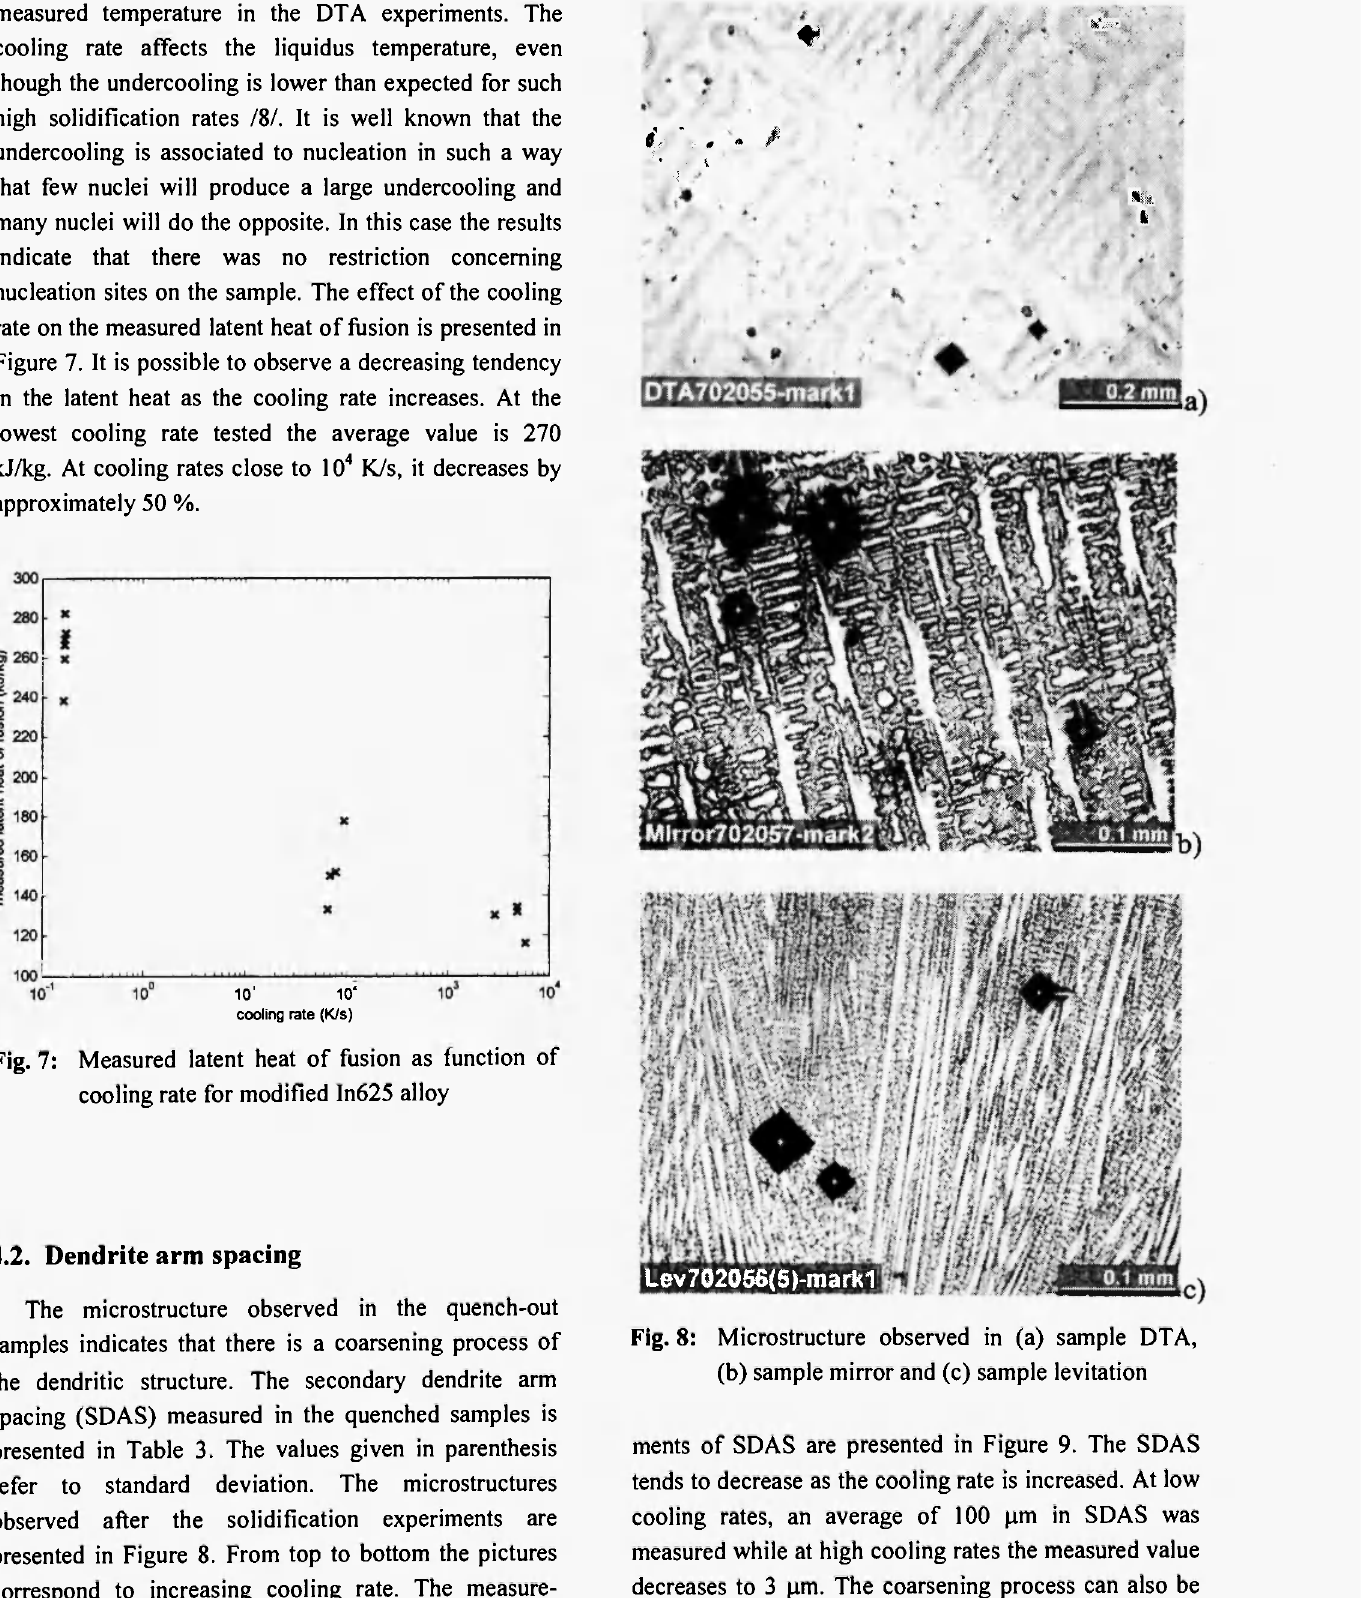
Fig. 8: Microstructure observed in (a) sample DTA, (b) sample mirror and (c) sample levitation